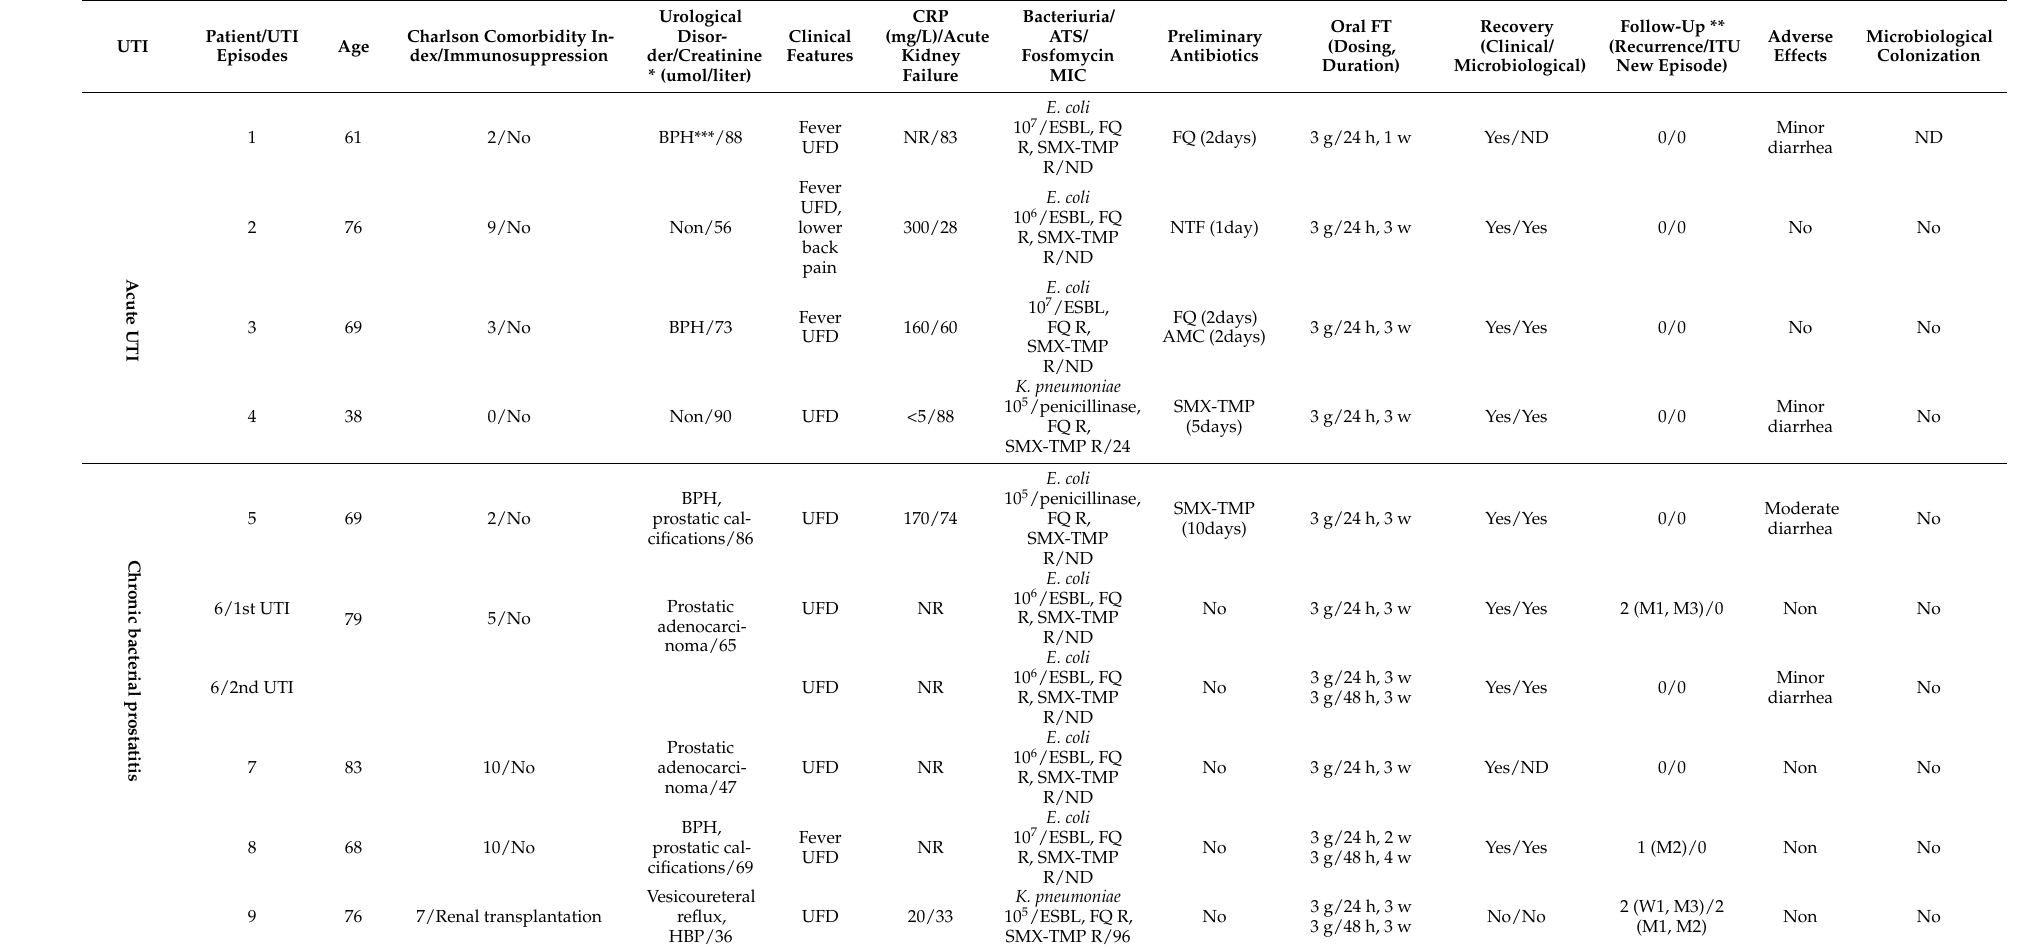
Table 1. Patient clinical and microbiological characteristics at baseline treated with oral